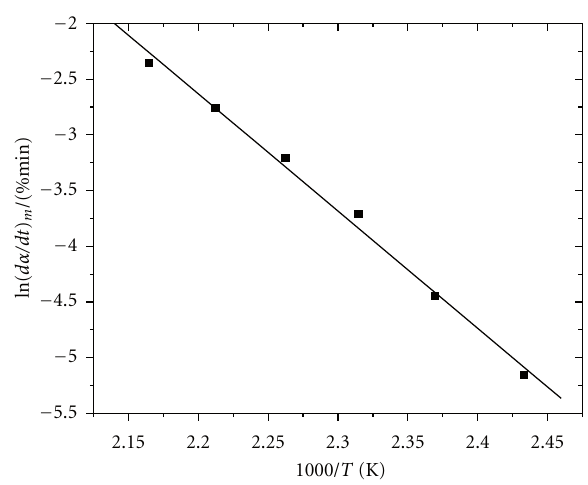
F 5: Friedmann isothermal plot of Zr